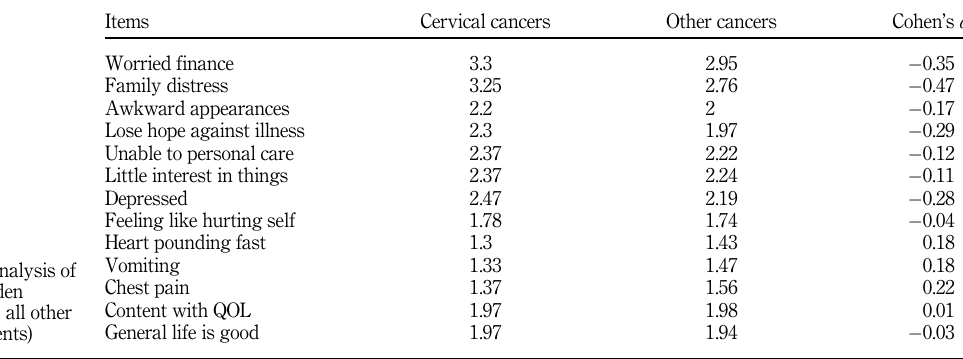
mental burden of the two groups divided by the pooled standard deviation (SD) for the entire group).